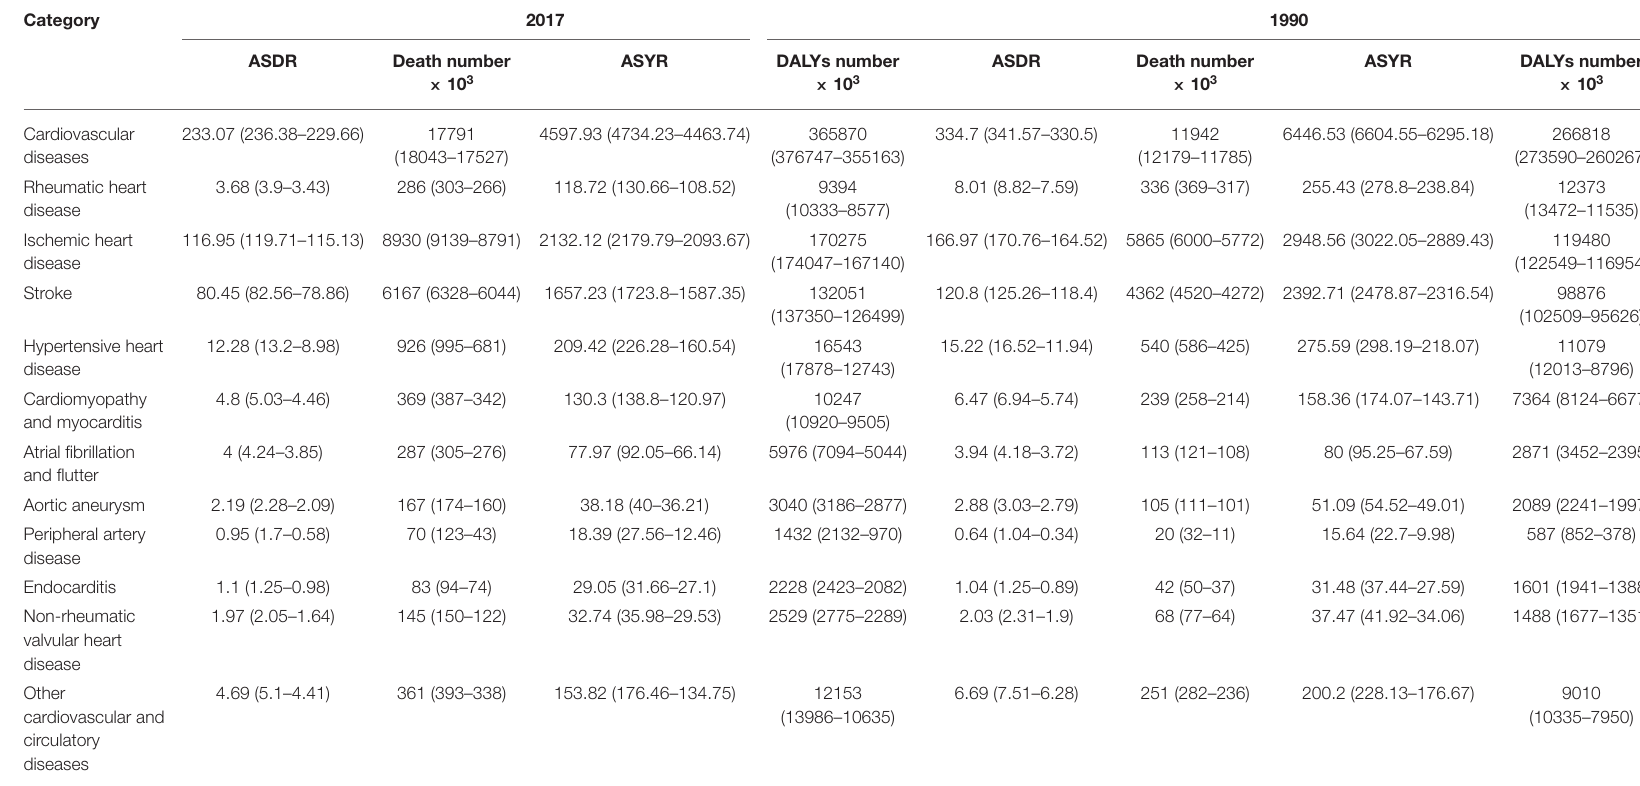
TABLE 1 | Total number and age-standardized rate of death (ASDR) and disability-adjusted life years (DALYs) of cardiovascular disease (CVD) and its 11 categories in 1990 and 2017.